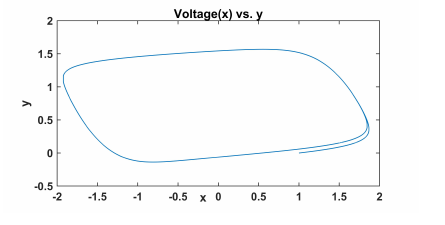
Figure 13. Responses of membrane potential with a constant external current value, I(t) = 2 µ A / cm 2 , a = 0.8 , b = 0.7 & c = 3